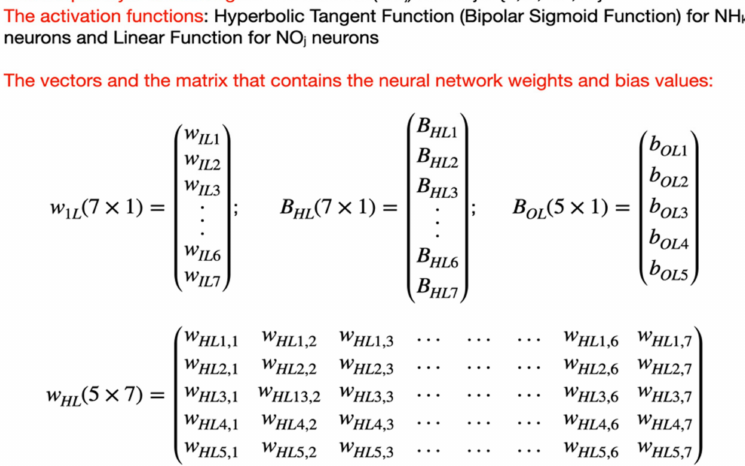
Figure 8. The structure and the details of the four proposed neural networks.